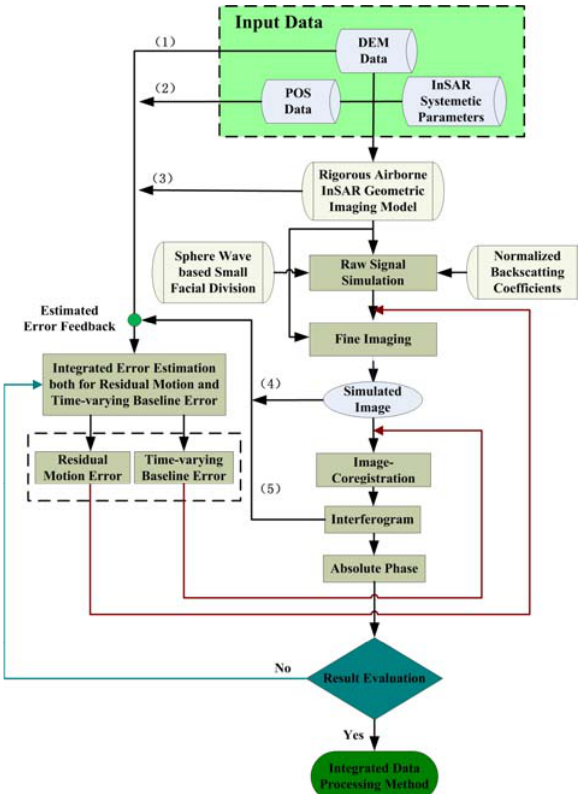
Fig. 2. Scheme of integrated estimation of residual motion and time-varying baseline